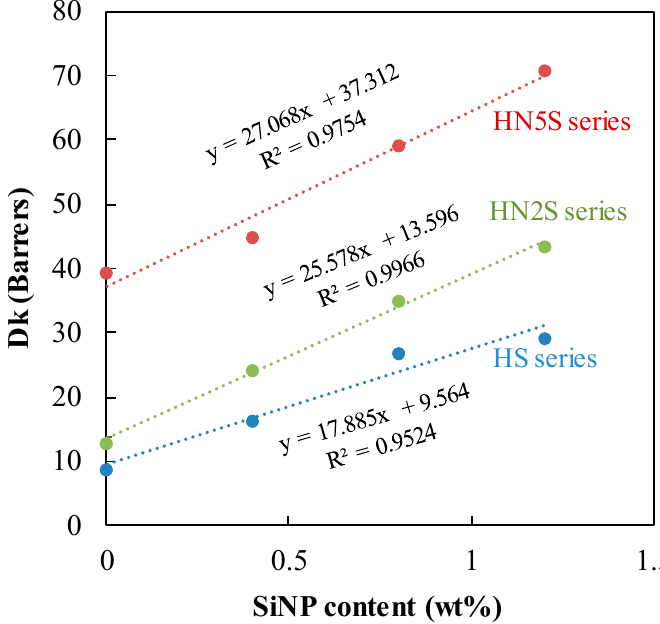
Figure 14. The e ff ect of SiNPs content on Figure 14. The effect of SiNPs content on Dk.